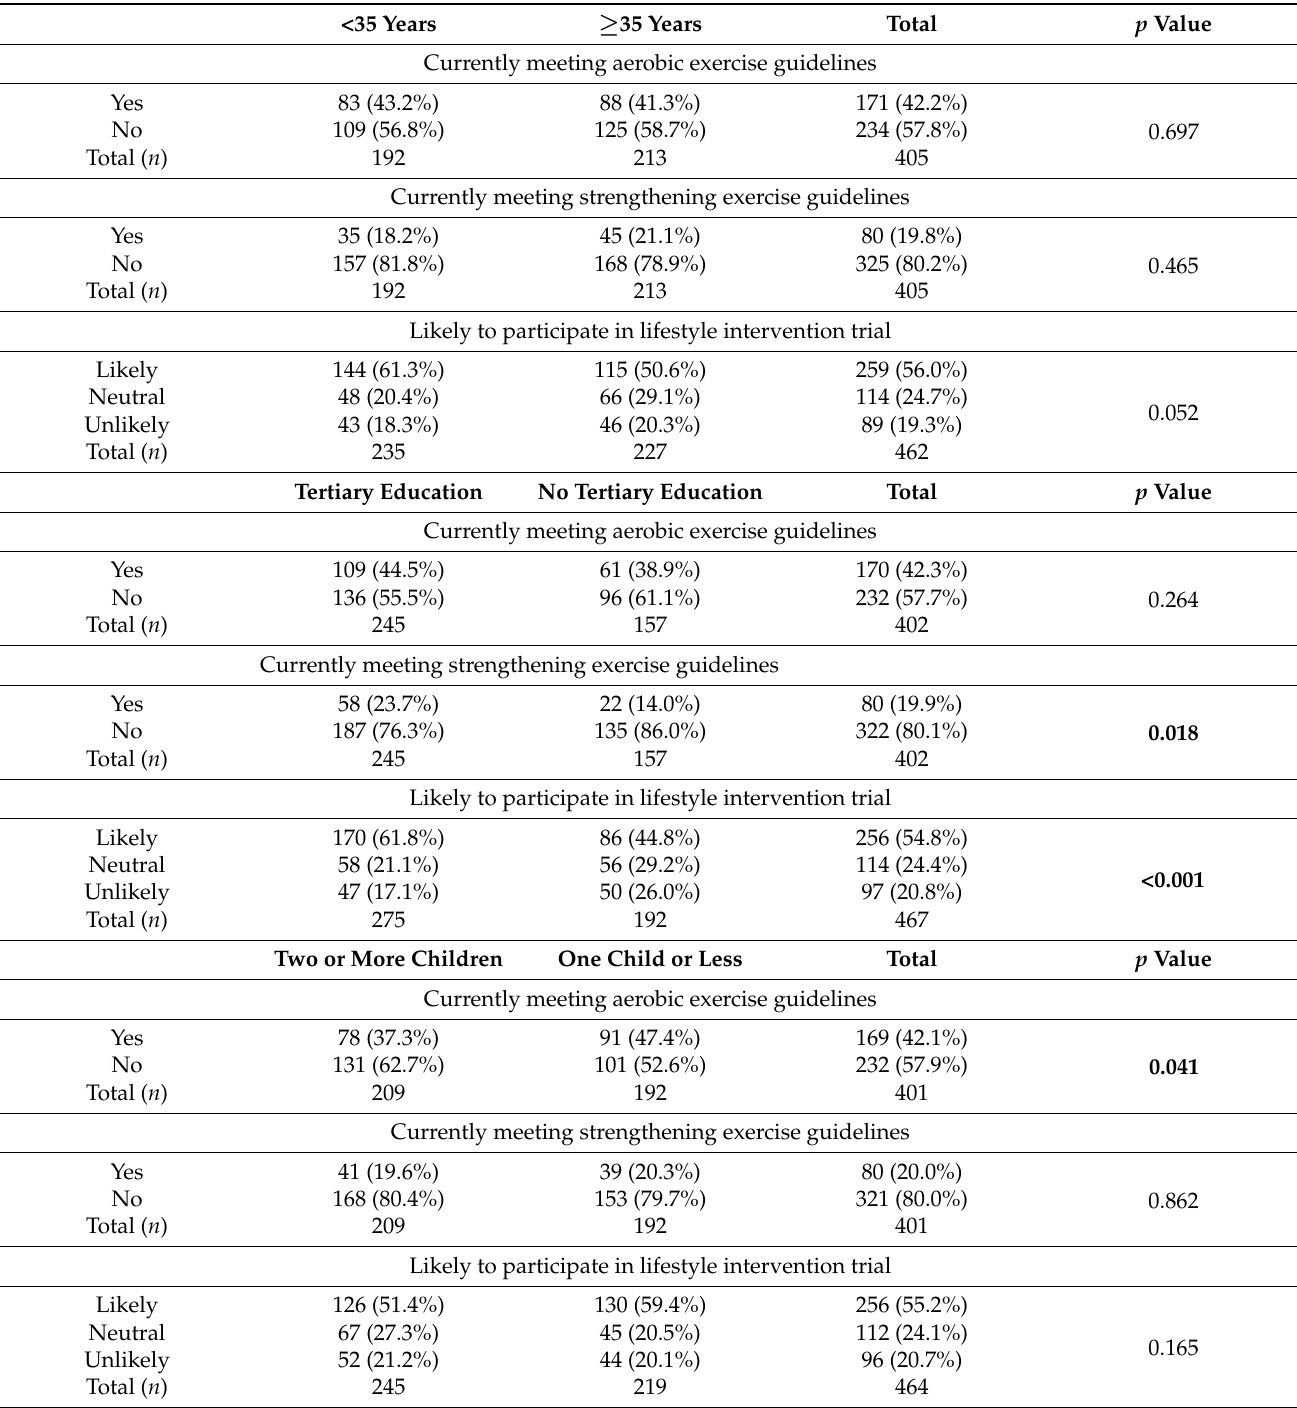
Table 3. Compliance with physical activity guidelines stratified by education and number of children. <35 Years ≥ 35 Years Total p